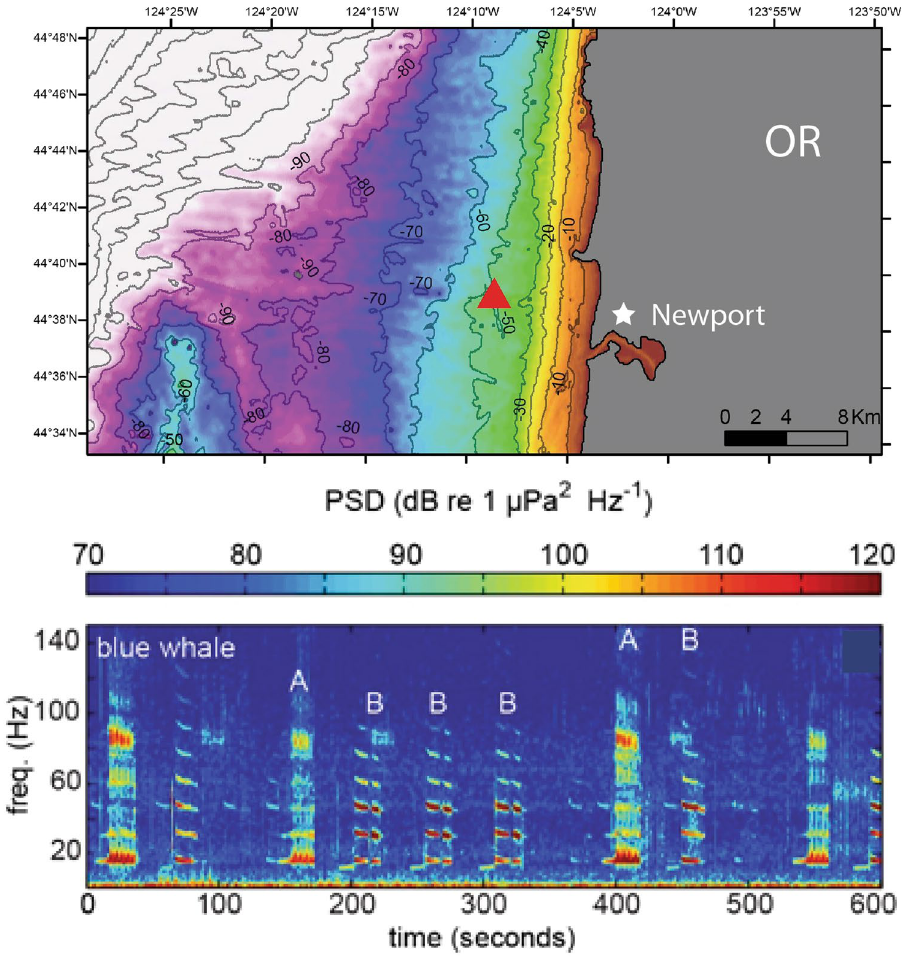
Figure 1. Top diagram shows location of hydrophone mooring (red triangle) ~8 km off the coast of Newport, Oregon. Seafloor depth contours are labeled. Bottom diagram shows example spectrogram of blue whale A and B calls recorded on the hydrophone (8 kHz sample rate) on 28 September at 01:57z (27 September at 18:57 PST). Bathymetric map was created using ArcGIS, [version 10.0], (http://www.esri.com/software/arcgis) software (Environmental Systems Research Institute) from a 100 m resolution xyz file of multibeam depth measurements, collected in 2011 by C. Goldfinger (Oregon State University, Active Tectonics